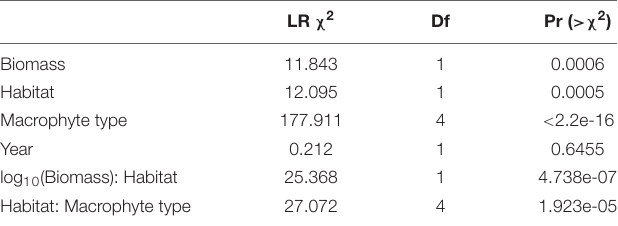
TABLE 3 | Type II Analysis of Deviance comparing the effects of habitat type (patch reef vs. fore reef), macrophyte type, key macrophyte consumer (Acanthuridae and Scaridae) biomass (log 10 -transformed), and year on the proportion of macrophyte types lost after 24